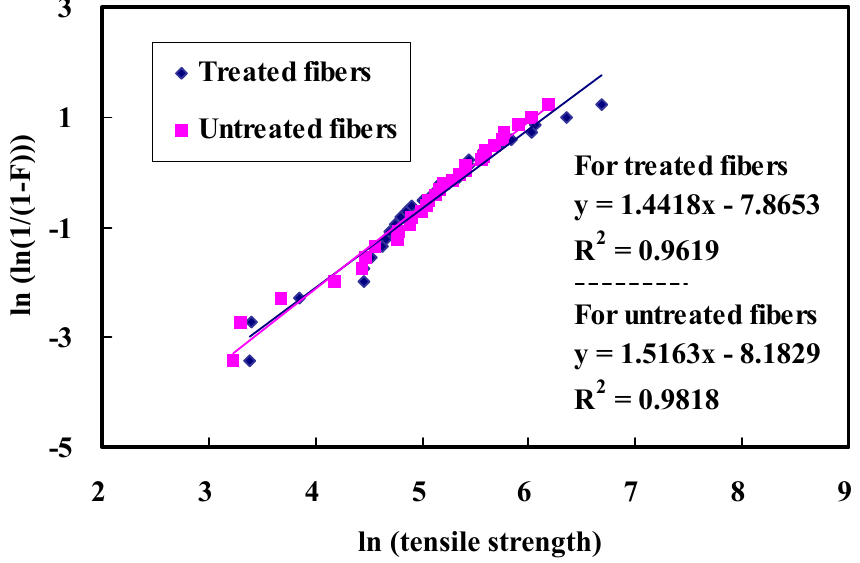
Figure 7. Weibull plots of the tensile strength of bamboo fibers before and after alkali treatment.